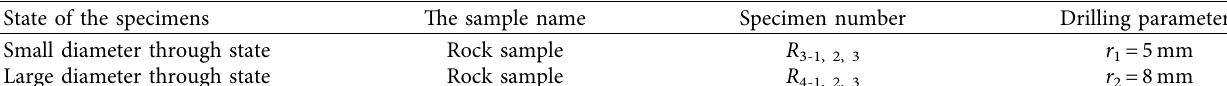
Table 2: Sample number and drilling parameters of each state.